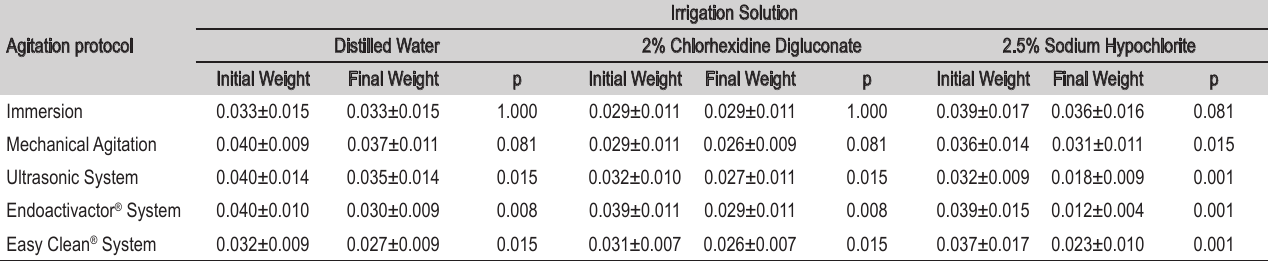
Table 2 - Comparison of irrigating solutions and agitation protocols as to the tissue dissolution